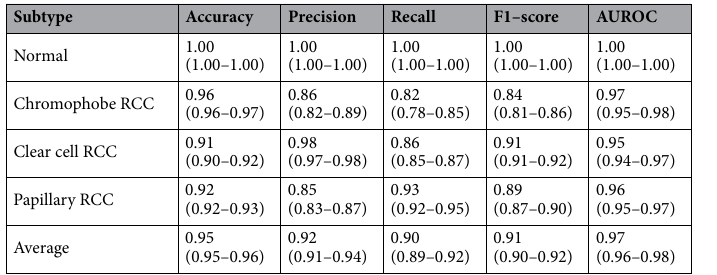
Table 2. Model’s performance metrics and their 95% confidence intervals on 917 surgical resection whole- slide images from the TCGA